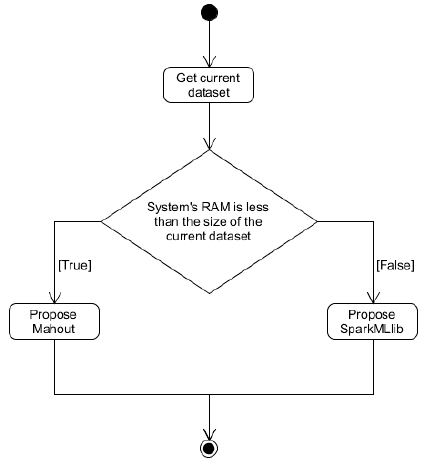
Figure 5. Analytics proposition